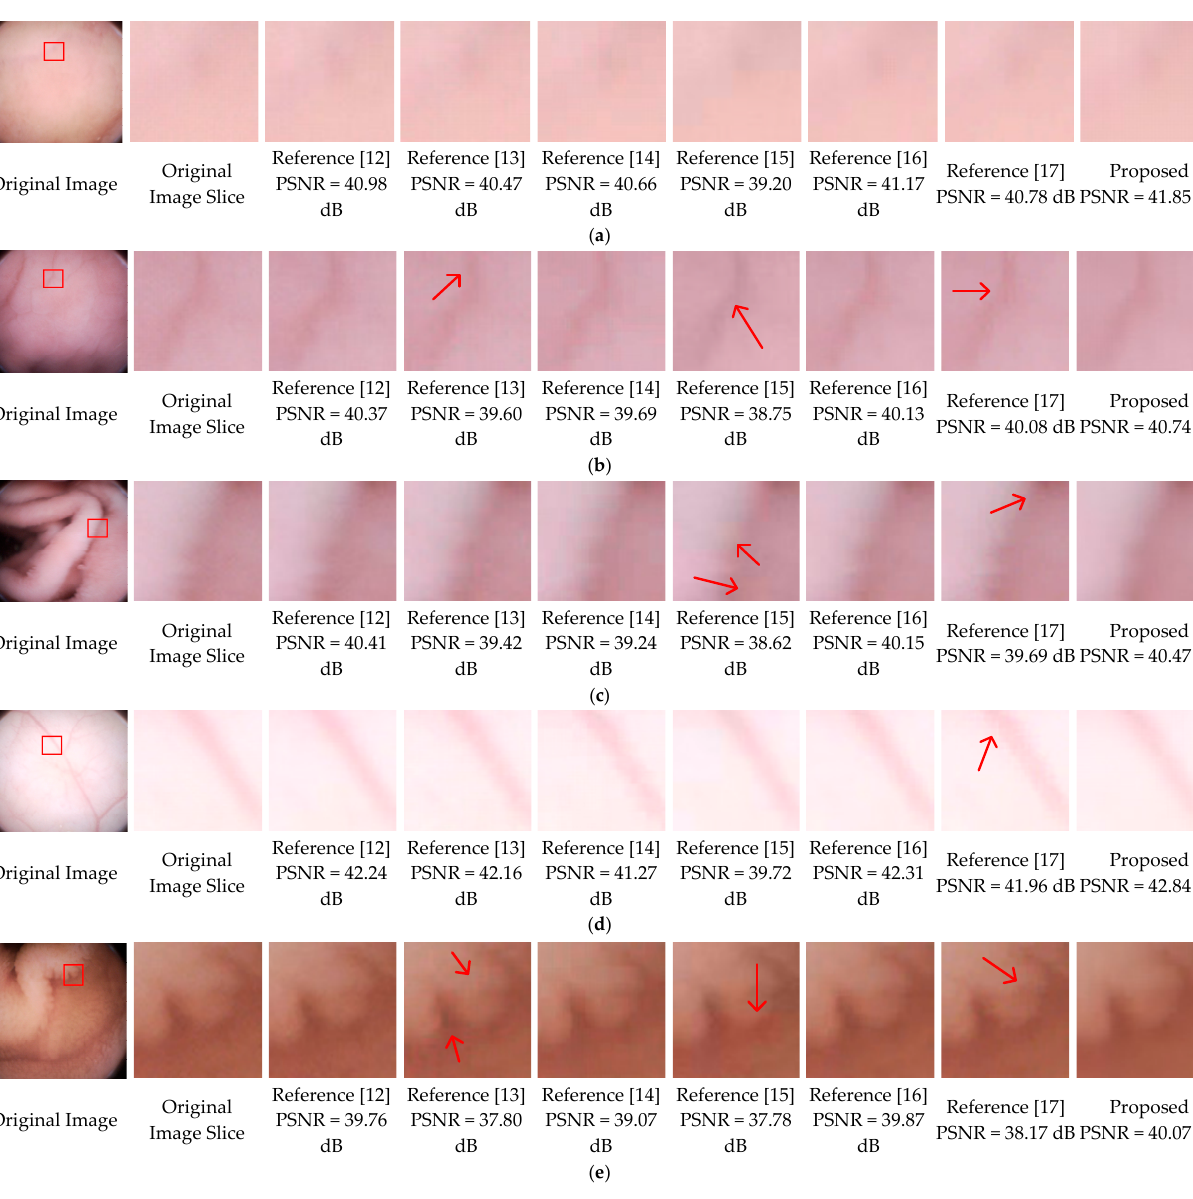
Figure 12. Final results comparison, where ( a ) is relatively flat, ( b – d ) have folds or vessels, ( e ) has rich villi.